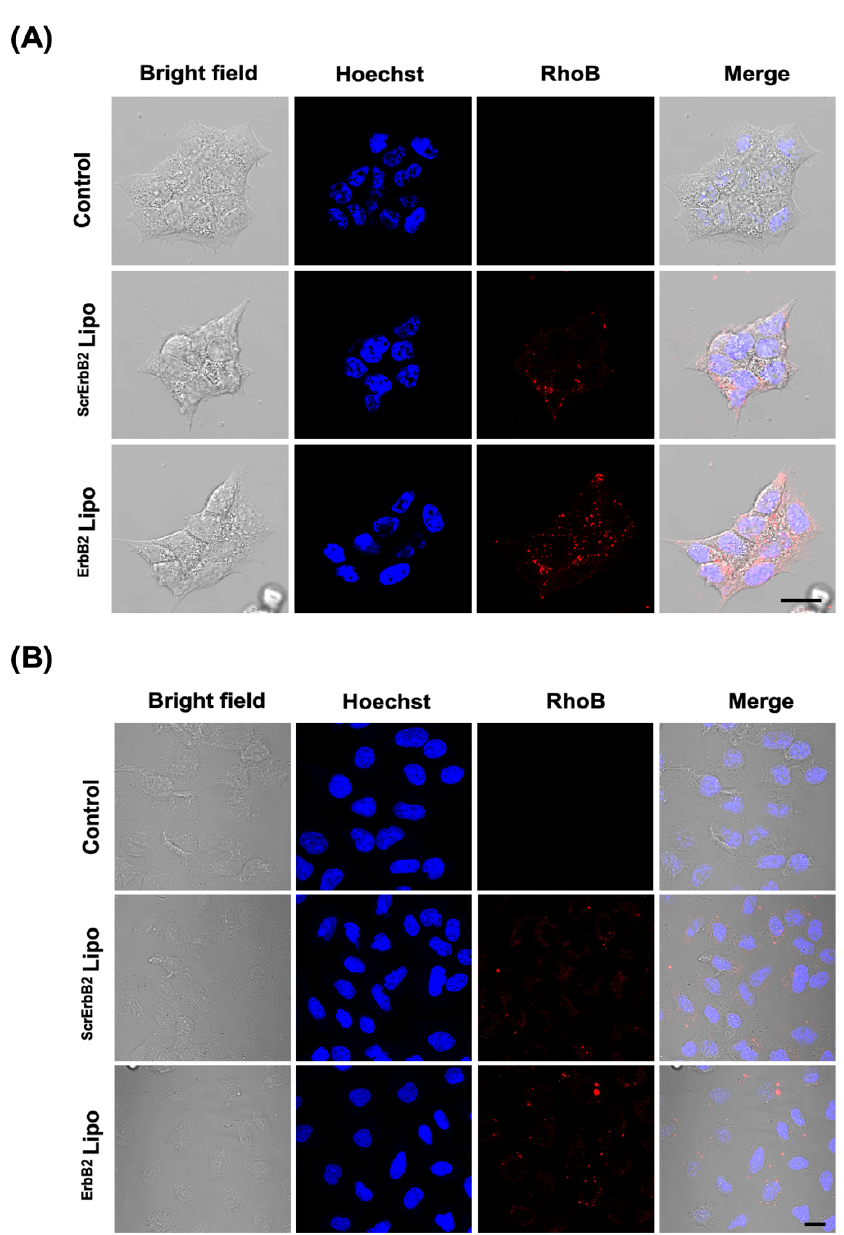
Figure 5. Cellular internalization of the ErbB 2Lipo. Representative confocal microscopy images of ( A ) BT-474 and ( B ) MDA-MB-231 cells after incubation for 3 h. Cell nuclei was stained with Hoechst 33342 (blue). Rhodamine B (red) indicated the presence of liposomes. Scale bar: 10 μ m.